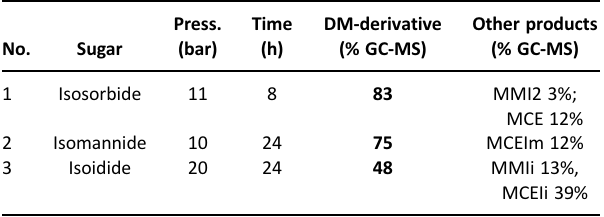
Table 6. Methylation of isosorbide and its epimers in autoclave using KW2000 as catalyst.